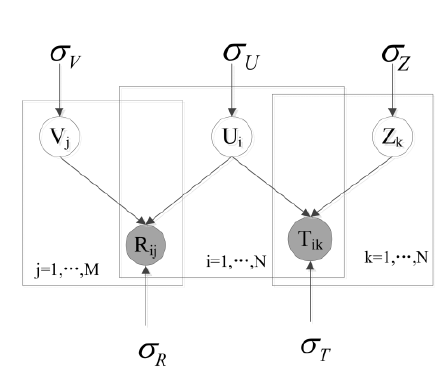
Figure 5. The probabilistic graphical model of SoRec.